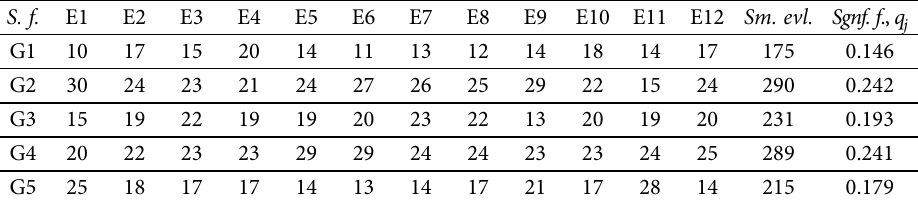
Table 19. The significance of factors in the group of a legal environment (for legal unprotected technology) regarding the commercial potential of technologies S. f.